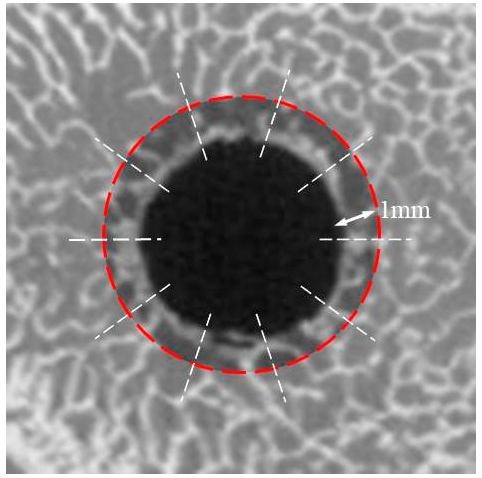
Figure 2. The region of interest to measure the difference in the Hounsfield unit of bone density test.